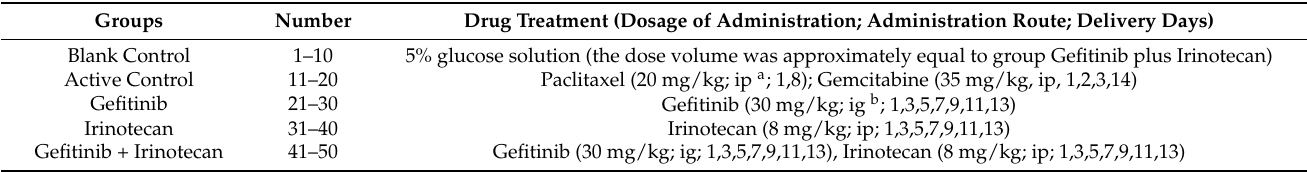
Table 2. Grouping of xenotransplantation experiments and drug treatment information.